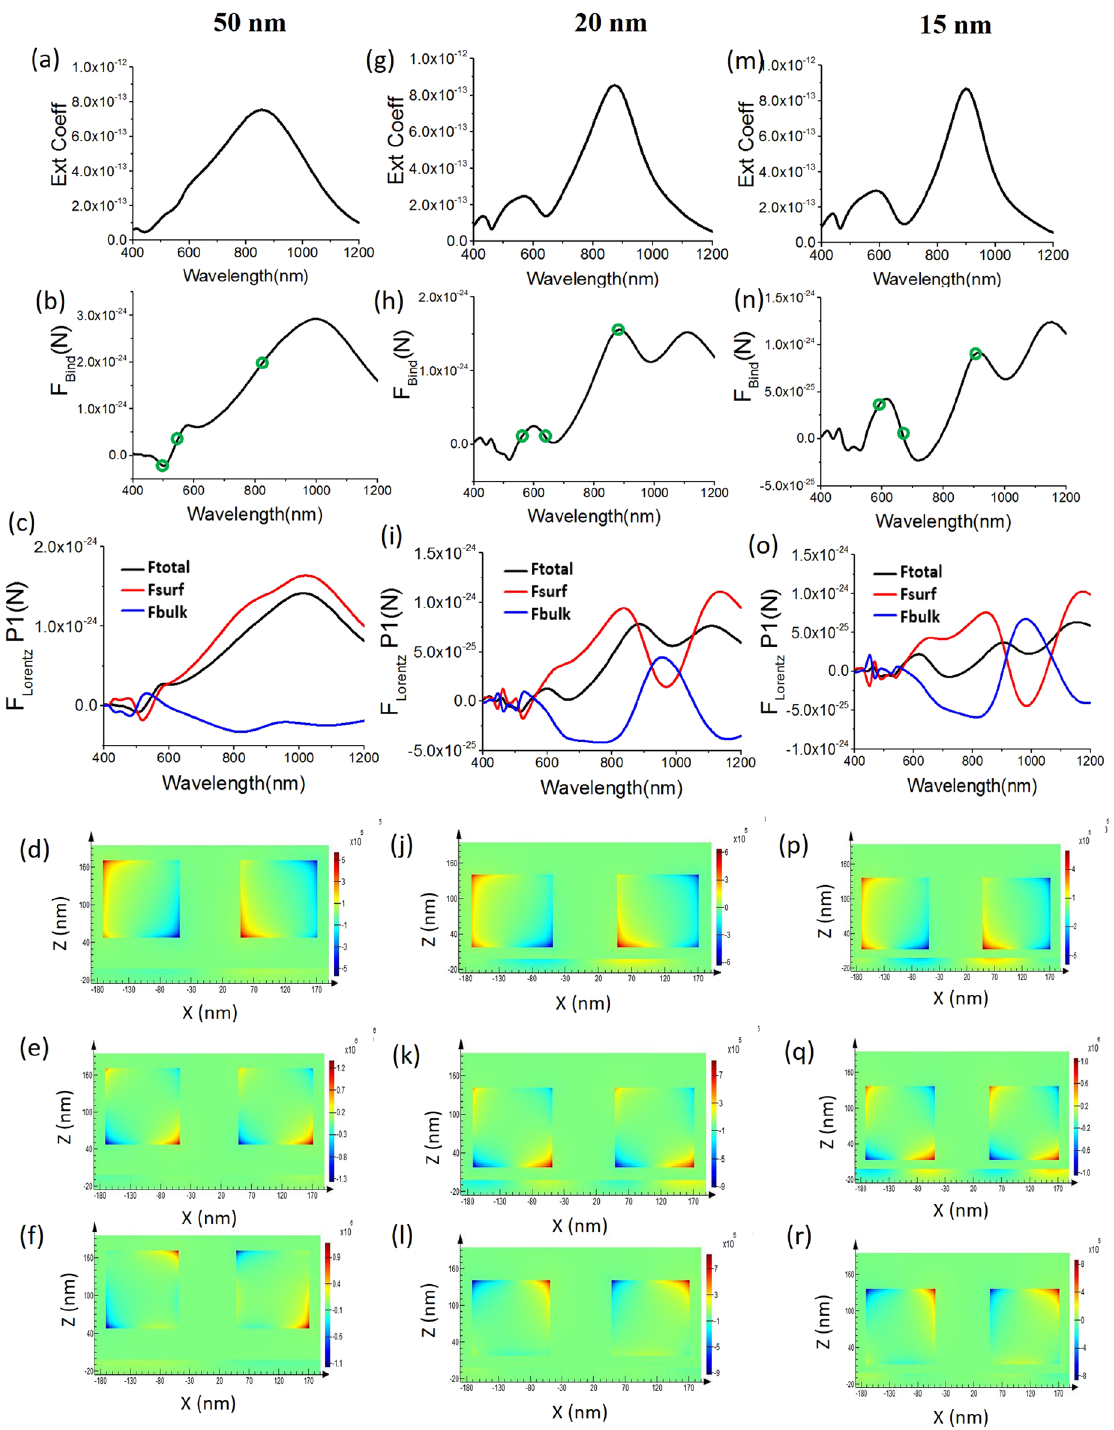
Figure 5. Two silver cubes (L = 120 nm) are placed at different heights from the silver substrates (three different columns represent the position of the cubes: 50, 20 and 15 nm away from the substrate) and their inter-particle gap, d , is fixed 100 nm. The spacer height is 5 nm. x -polarized plane wave is propagating towards –z -direction. For different heights from the substrate: First row: extinction co-efficient; second row: binding force; ‘°’ represents the chosen wavelengths for which the steady state current distributions are plotted later. Third row: Lorentz force components along with the total force only on cube-1 (left cube, denoted as P1); fourth, fifth and sixth row: steady state current ( J y ) from front view [in xz plane; setting the window very close to the cube surfaces from front view] for two silver cubes along with the substrate in three different wavelengths (marked as ‘ ° ’). For first column [50 nm height, ( d–f )] wavelengths are chosen as: 855, 553 and 503 nm respectively. For second column [20 nm height, ( j–l )] resonance wavelengths are: 872 (DD), 631 (Fano) and 567 nm (QQ) respectively. For third column [15 nm height, ( p–r )] resonance wavelengths are: 890 (DD), 674 (Fano) and 590 nm (QQ)